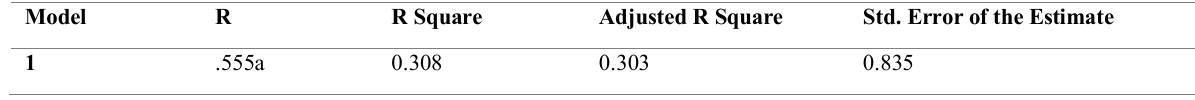
Table 5: Model Summary; Institutional Processes and Performance model